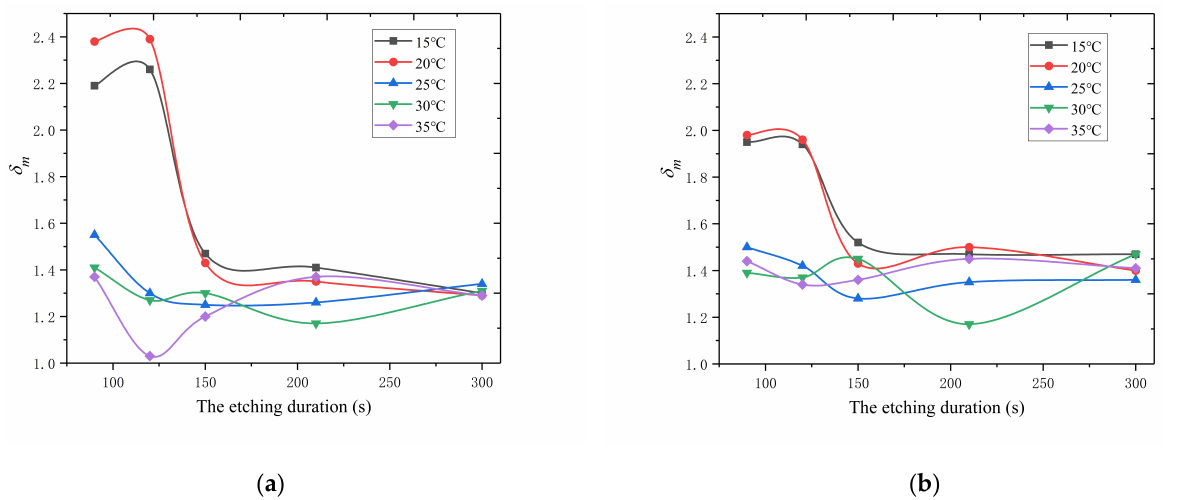
Figure 8. The dependence of surface δ m values on etching parameters. ( a ) Before gold coating; ( b ) after 100 nm gold coating.